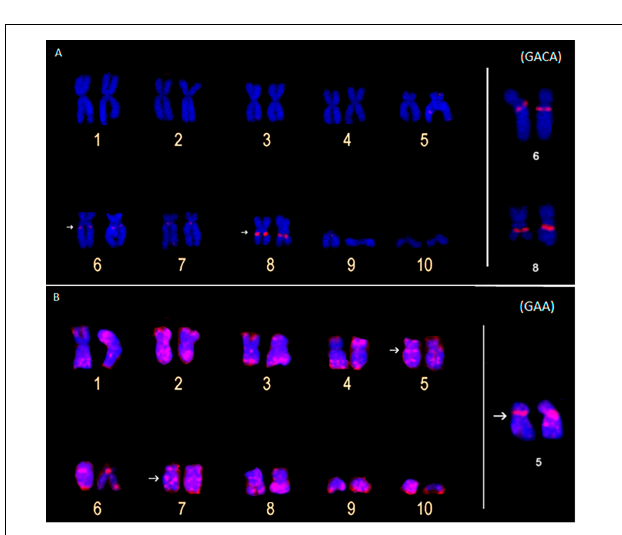
FIGURE 4 | Metaphase chromosomes of Pipa carvalhoi submitted to fluorescent in situ hybridization with probes for the microsatellite repeats (GACA)4 (A) and (GAA)10 (B) . The arrows indicate the minor hybridization signals detected in the non-terminal regions of the